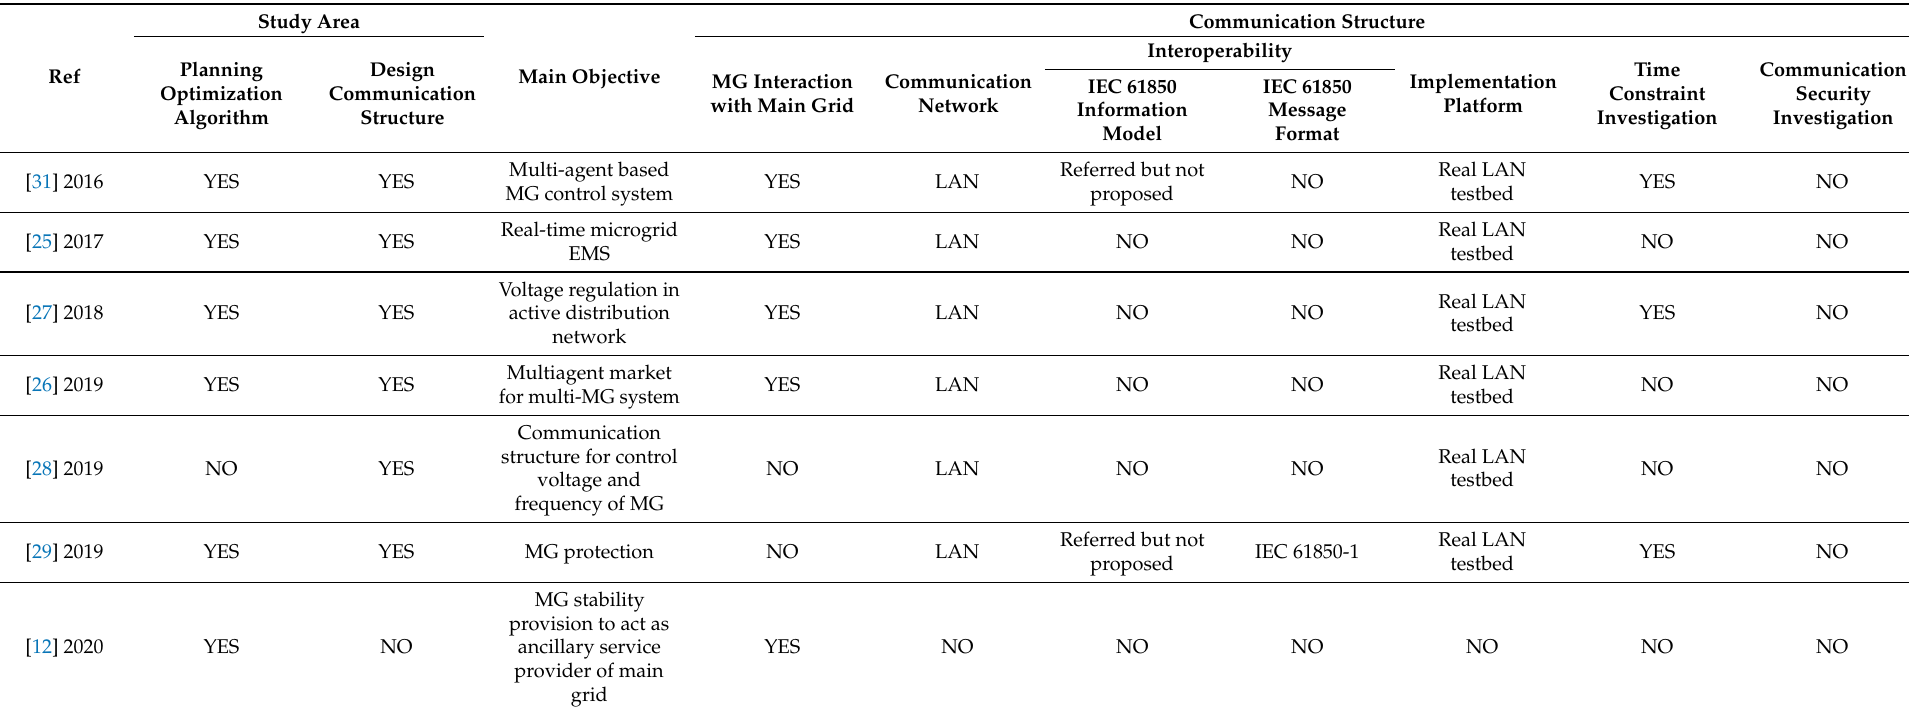
Table 1. Microgrid as ancillary service provision, related works’ objectives